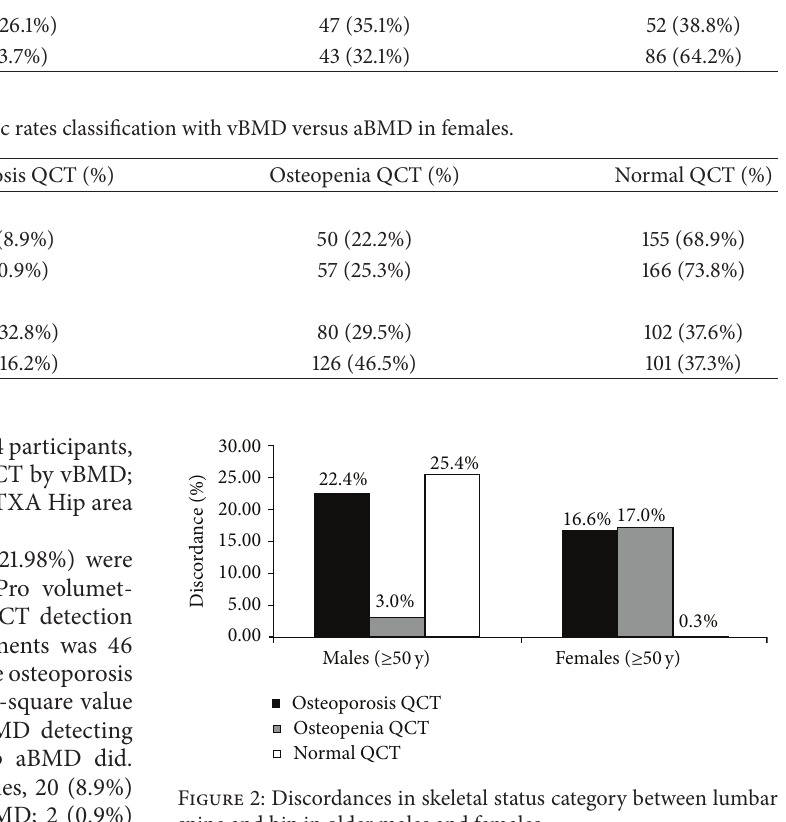
Figure 2: Discordances in skeletal status category between lumbar spine and hip in older males and